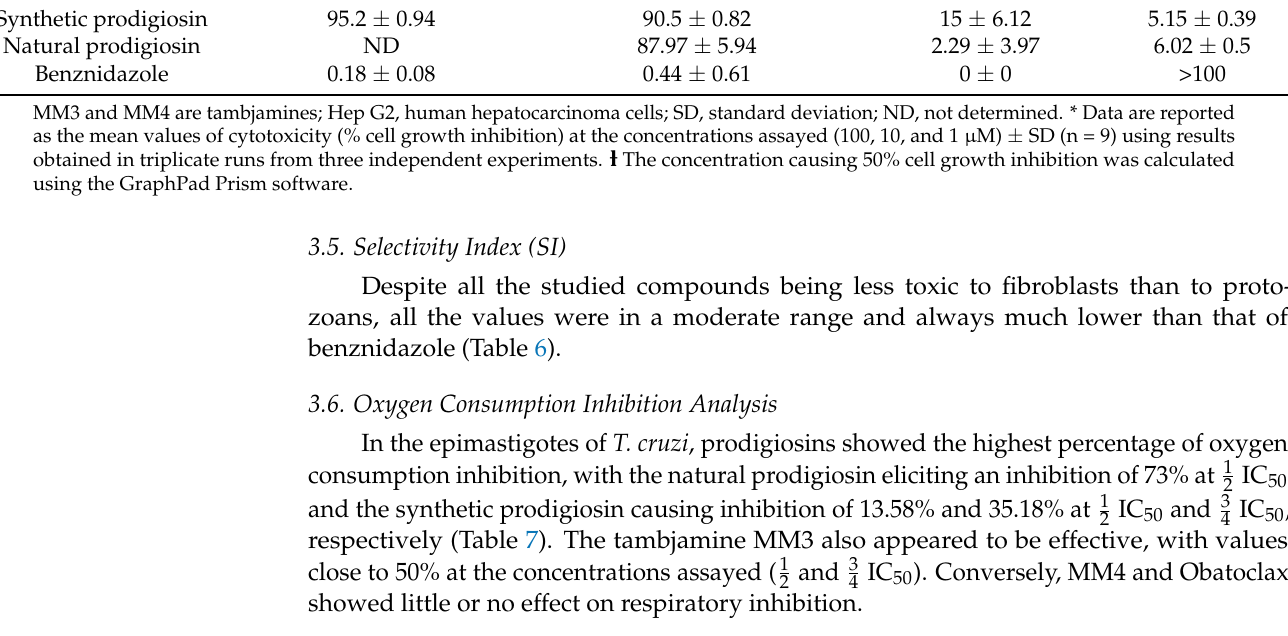
Table 2. Biological activity of tambjamines, Obatoclax, synthetic and natural prodigiosins, and benznidazole against trypomastigotes/amastigotes of T. cruzi (CLB strain) at the highest concentra- tion assayed (16